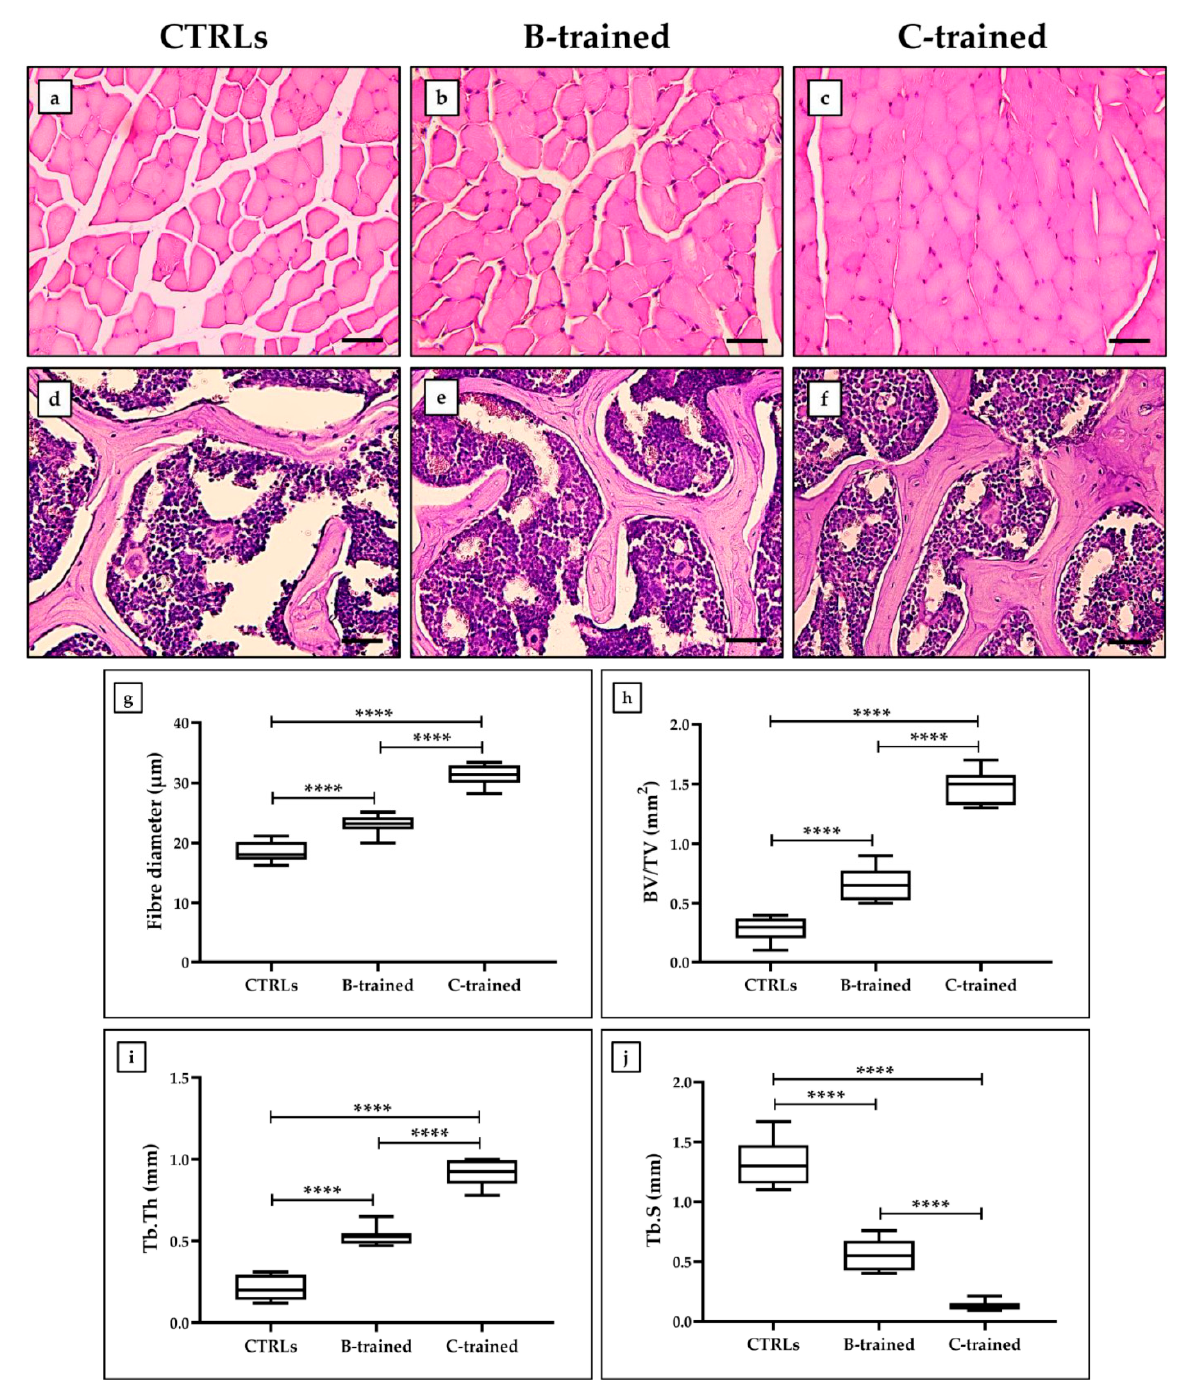
Figure 4. Hematoxylin and eosin (H&E)-stained sections of muscle and bone tissues from the different experimental groups. ( a – c ) Polygonal and multinucleated skeletal muscle fibers and peripheral nuclei were evident in the muscle tissue of each experimental group. A complete organization of the fibers into fascicles was observed in the C-trained group. ( g ) The muscle fiber diameter is shown for each experimental group (**** p < 0.0001; F = 114.8). ( d – f ) Thicker and more voluminous trabecular bones were observed in the C-trained group. ( h ) The bone volume (BV/TV) is shown for each experimental group (**** p < 0.0001; F = 180.7). ( i ) The trabecular thickness (Tb.Th) is shown for each experimental group (**** p < 0.0001; F = 189.4). ( j ) The trabecular separations (Tb.S) is shown for each experimental group (**** p < 0.0001; F = 160.4). For 20× images, scale bar represents 50 μ m.